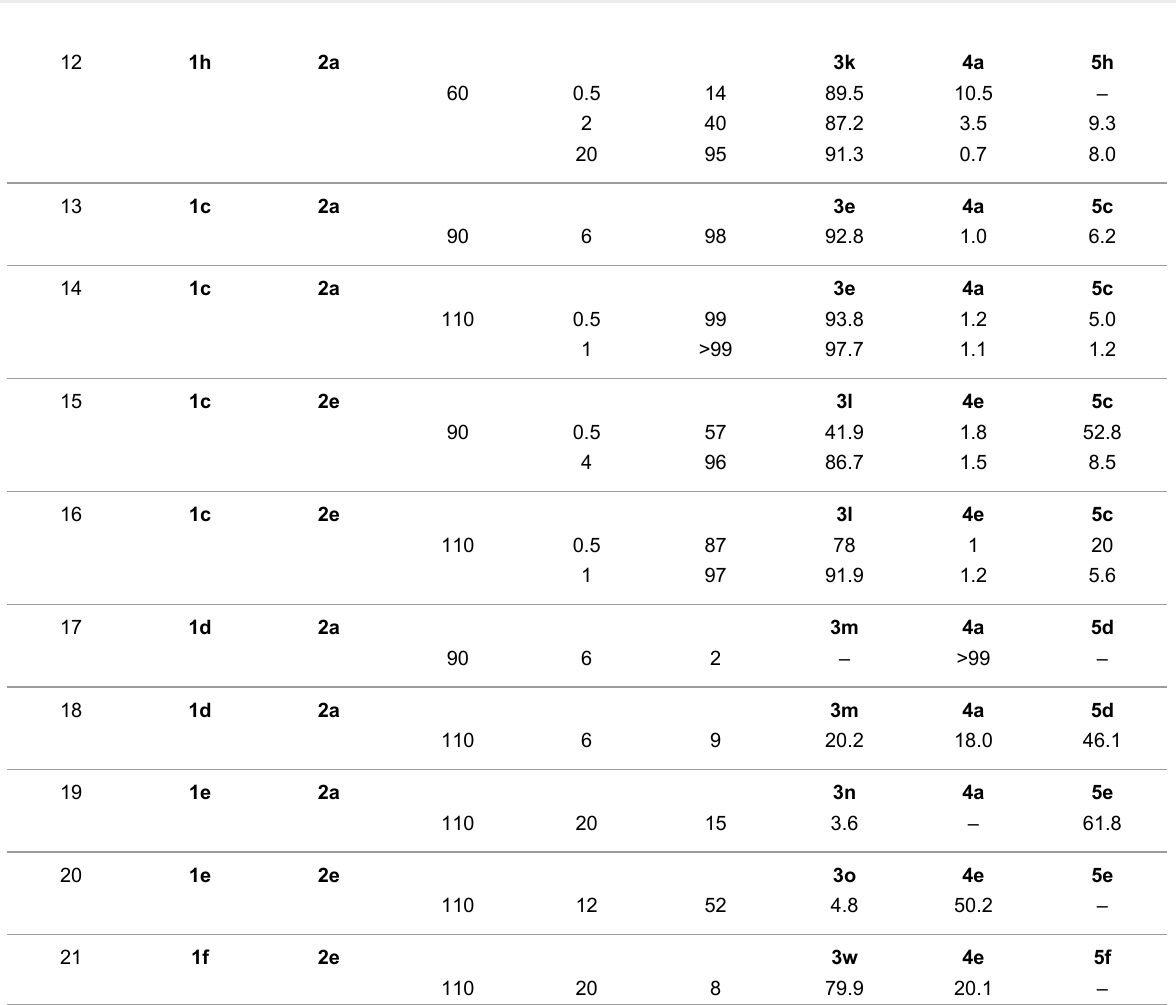
Table 2: Synthesis of thioethers from different alcohols and thiols promoted by SiAl 0.6 without solvent a .